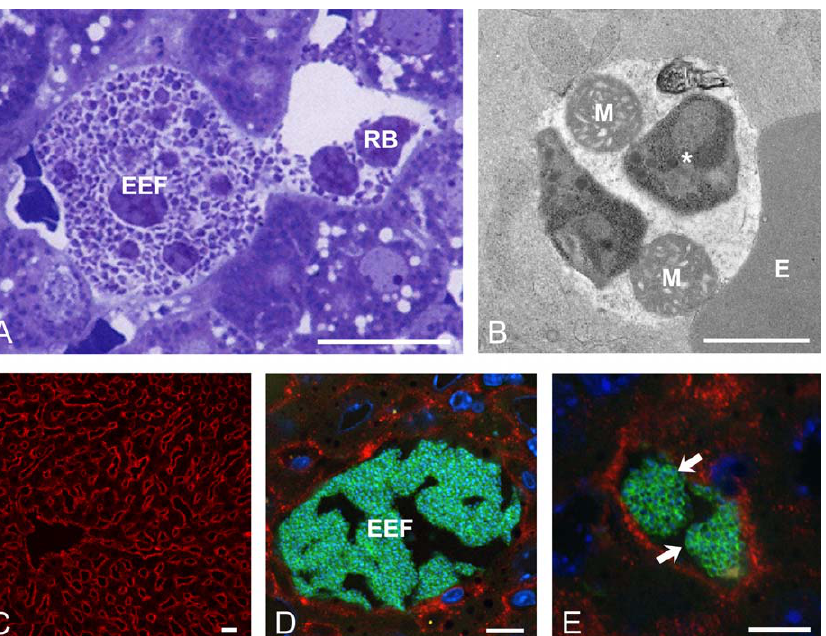
Figure 6. Merosomes Contain Viable Merozoites and Host Cell Organelles (A) Semithin section showing an EEF releasing a merosome into a sinusoid. Note that remnant bodies are a normal component of the merosomal cytoplasm. RB, remnant bodies. Bar ¼ 10 l m. (B) Electron microscopy documents that merosomes contain well-preserved merozoites and hepatocyte mitochondria. E, erythrocyte; M, hepatocyte mitochondria; *, merozoite. Bar ¼ 1 l m. (C) Immunolabeling of frozen liver sections for ASGR-1 reveals the presence of the receptor on the basolateral portion of the membrane of all hepatocytes (red). Bar ¼ 20 l m. Neither EEFs (D) nor merosomes (E, arrows) express ASGR-1 on their surface. The merozoites were visualized with Hoechst (blue) and an antibody against MSP-1 in combination with PA-FITC (green). Bars ¼ 10 l m.